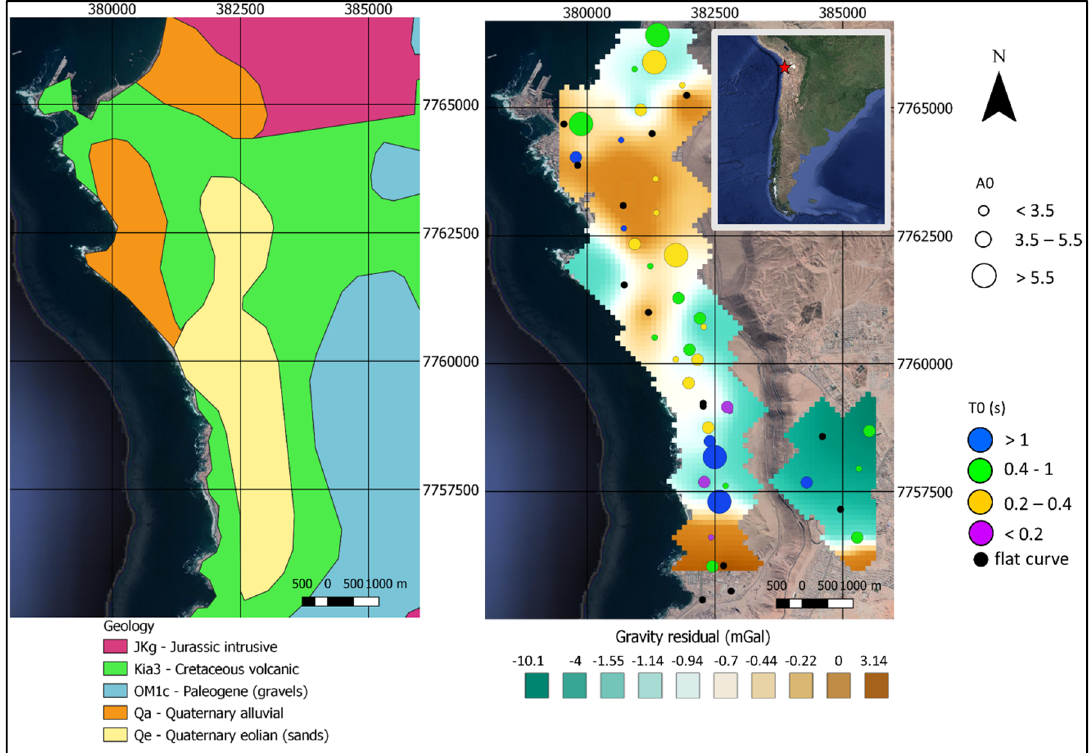
Figure 3. Iquique. Left panel: Simplified geology of the city adapted from Chilean geological map 1:1,000,000 [36]. Right panel: Main results of the geophysical campaign [14,36,39,42]. The color grid shows the gravity residuals in mGal. The color points show the H/V results. Color indicates the predominant period (T0) in seconds and the size indicates the amplitude (A0) of the H/V curve.